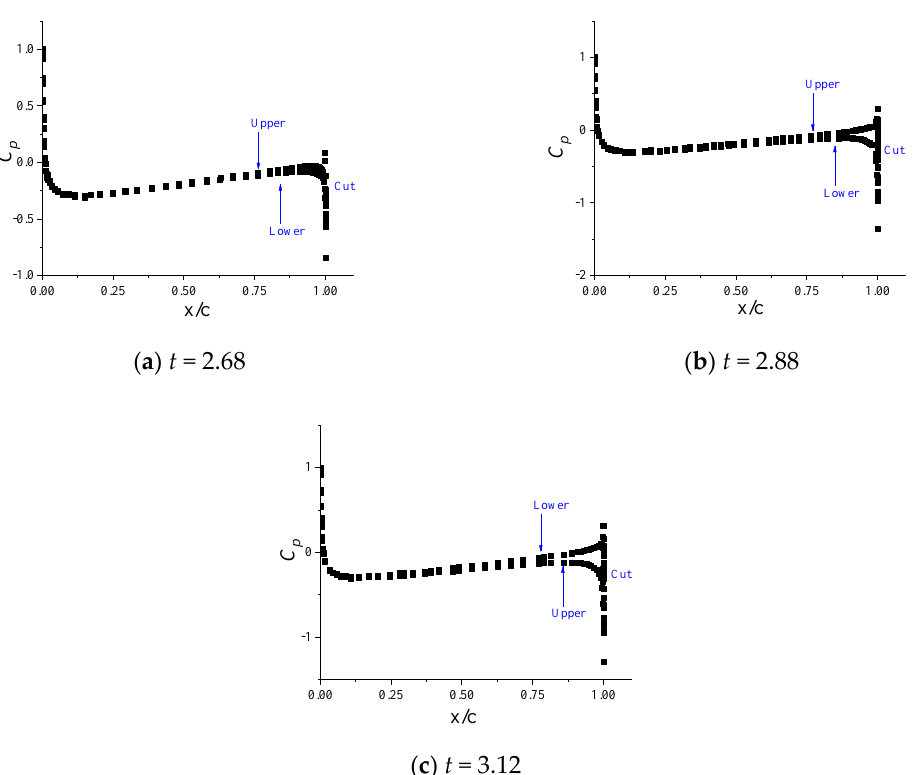
Figure 8. Distribution of the pressure on the surfaces of the hydrofoil over time.